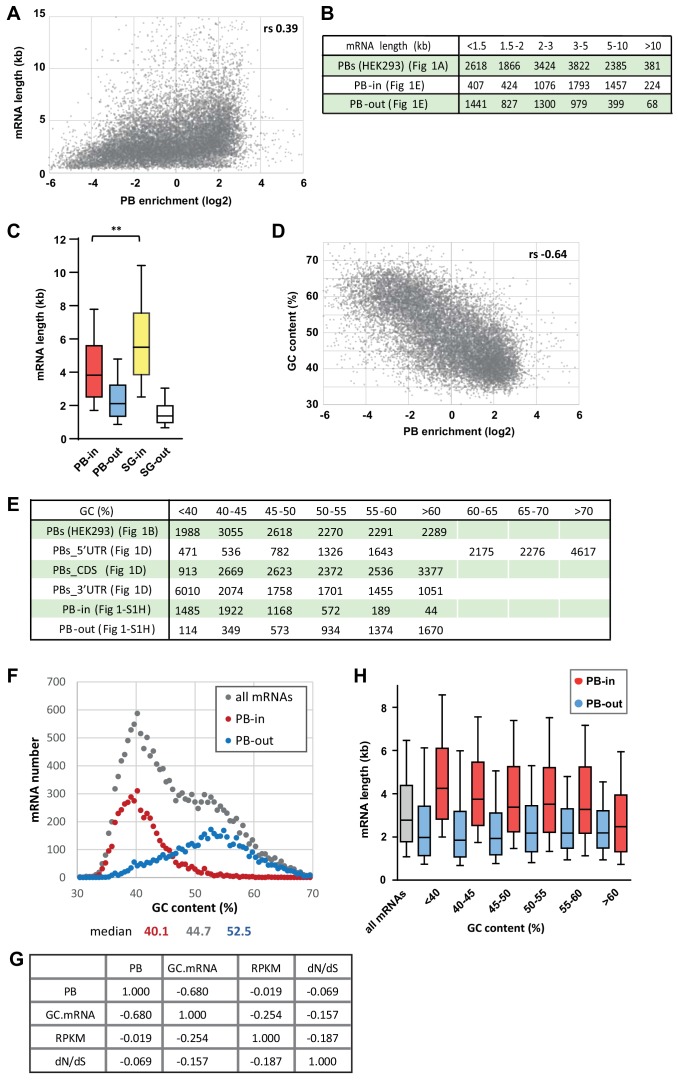
PB-enriched mRNAs tend to be long and AU-rich.(A) The transcripts enriched in PBs tend to be long. The mRNA length was expressed as a function of PB enrichment. rs, Spearman correlation coefficient.(B) Number of transcripts in the different classes analyzed in Figure 1A,E. (C) PB mRNAs are longer than PB-excluded ones, but shorter than SG mRNAs. The boxplot represents the distribution of length of PB-enriched (PB-in) and PB-excluded (PB-out) mRNAs, and SG-enriched (SG-in) and SG-depleted (SG-out) mRNAs, as taken from Wells et al. (2017). The length of PB-enriched and SG-enriched mRNAs was statistically different using a two-tail Mann-Whitney test. **, p<0.0001. (D) The transcripts enriched in PBs tend to be AU-rich. The mRNA GC content was expressed as a function of PB enrichment. rs, Spearman correlation coefficient. (E) Number of transcripts in the different classes analyzed in Figure 1B,D and Figure 1—figure supplement 1. (F) PBs mostly contain transcripts from AU-rich genes. The graph was constructed as in Figure 1C using the GC content of the genes. The median value is indicated below for each group. (G) Partial correlations between PB localization (PBs), mRNA GC content (GC.mRNA), mRNA expression (RPKM) and sequence conservation (dN/dS). For each line, individual cells represent the correlation between the two corresponding variables, controlling for the effects of all other variables. dN/dS is the ratio of non-synonymous (dN) to synonymous (dS) changes between two organisms, here computed between human and mouse. It is used as a measure of natural selection strength in coding sequence. (H) PB-enriched mRNAs are longer than PB-excluded ones independently of their GC content. The distribution of length of PB-enriched (PB-in) and PB-excluded (PB-out) mRNAs was analyzed as in Figure 1E.